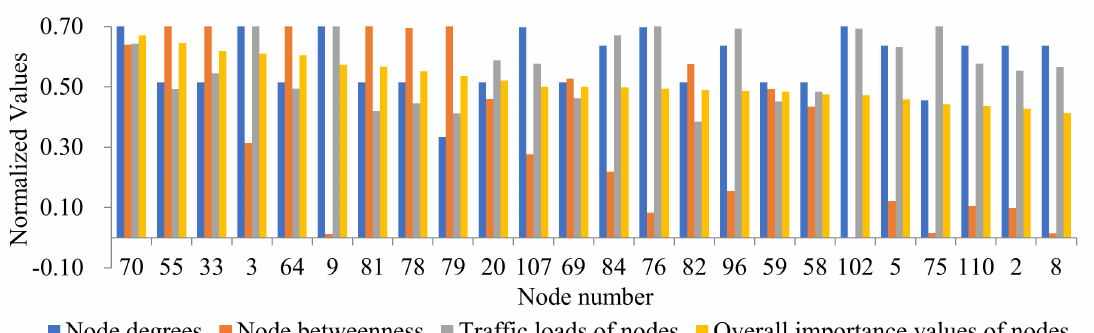
Figure 15. Ranking of the first-grade nodes.